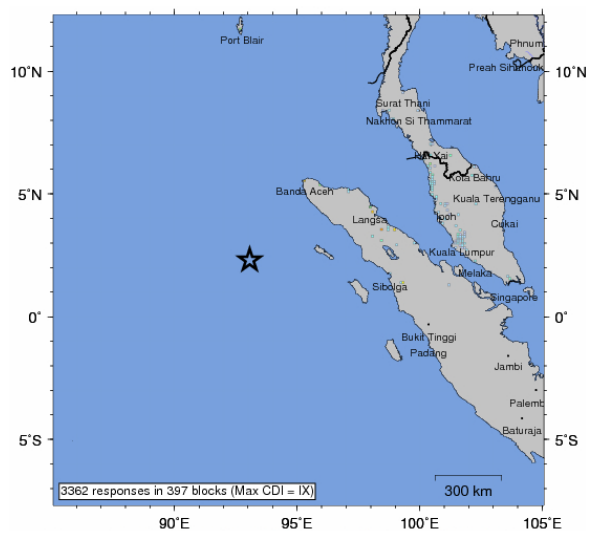
Figure 10. The geographic location of Indian earthquake epicen- ter. A vacant star represents epicenter. (Figure taken from: http:// earthquake.usgs.gov).